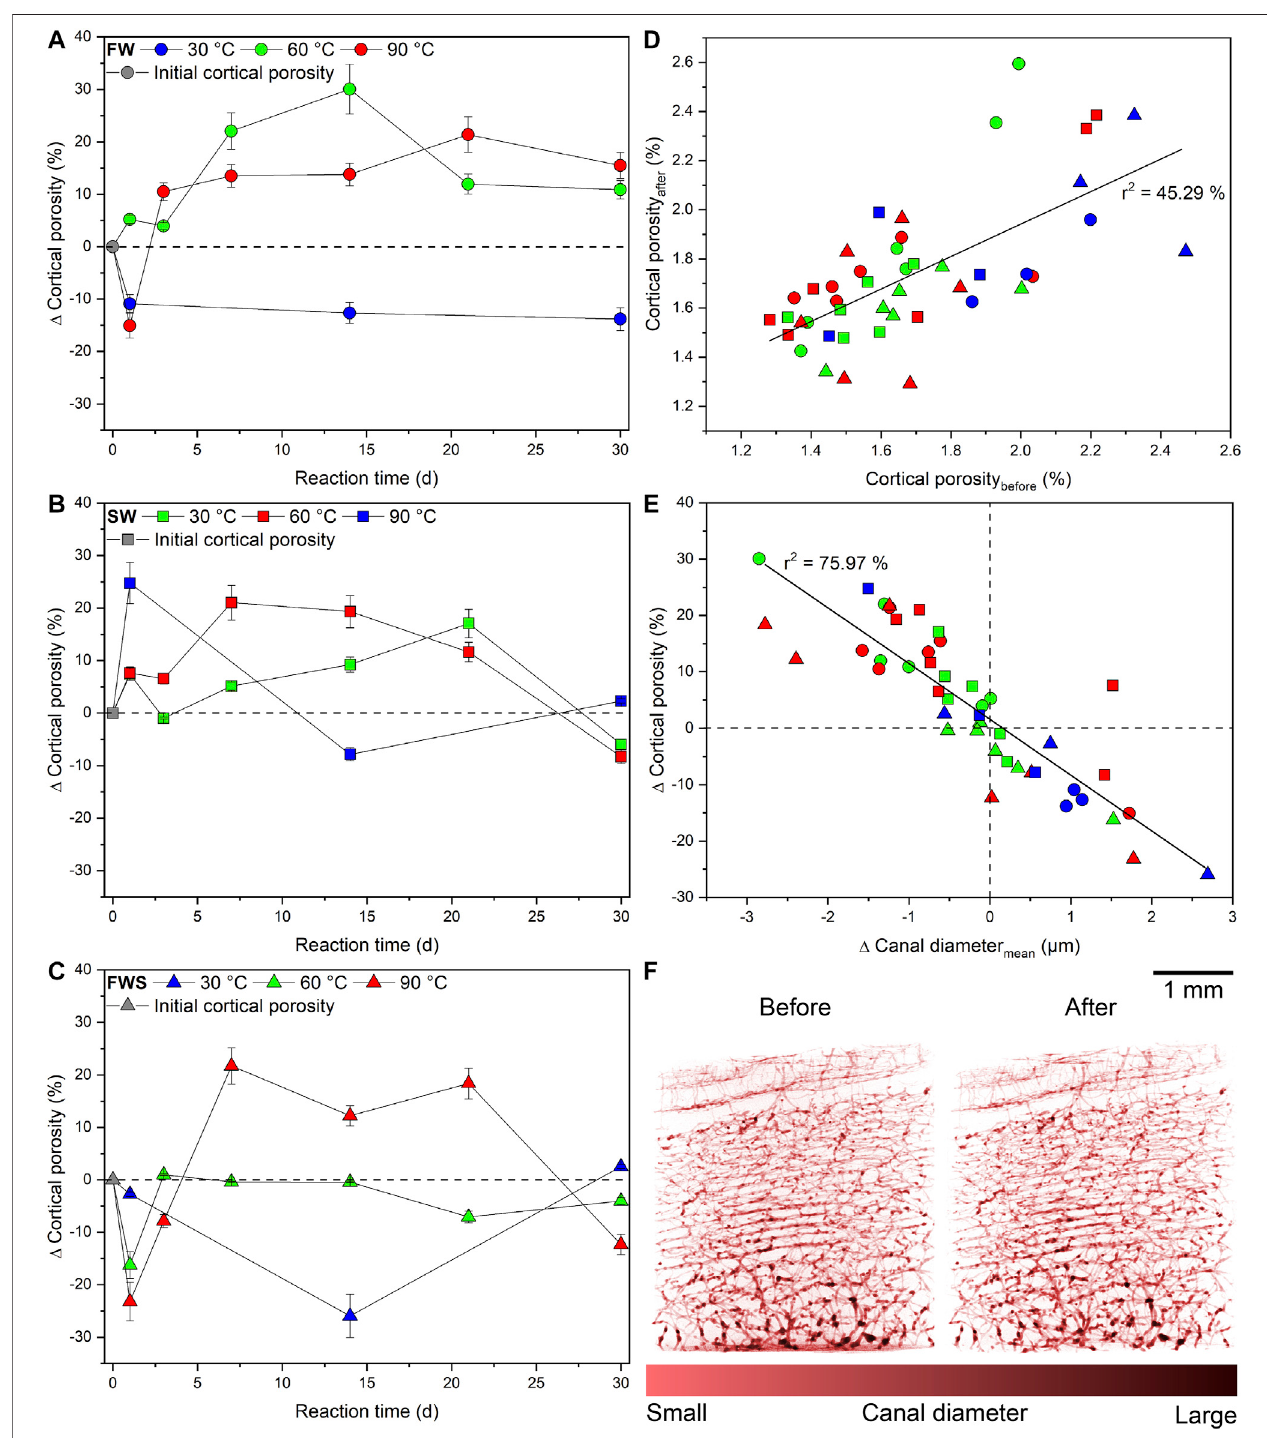
FIGURE6| Changesincorticalporosityobservedduringtheexperiments. (A-C) Changesincorticalporositygivenaspercentagedifferencefromtheinitialvalueas afunctionoftimewith2-sigmaerrorbars. (D) Relationshipbetweenthecorticalporositybeforeandaftertheexperiments. (E) Differencesincorticalporosityasafunction of the average canal diameter of each sample. (F) Comparative volume renderings of the cortical canal network from the sample with the most signi fi cant observed quantitativechangesincorticalporositybeforeandaftertheexperiment(FWS,30 ° C,14 d).Thedashed referencelinesin (A-C,E) representtheinitialvalueofeach data point. Fitted linear functions are displayed as a straight line.